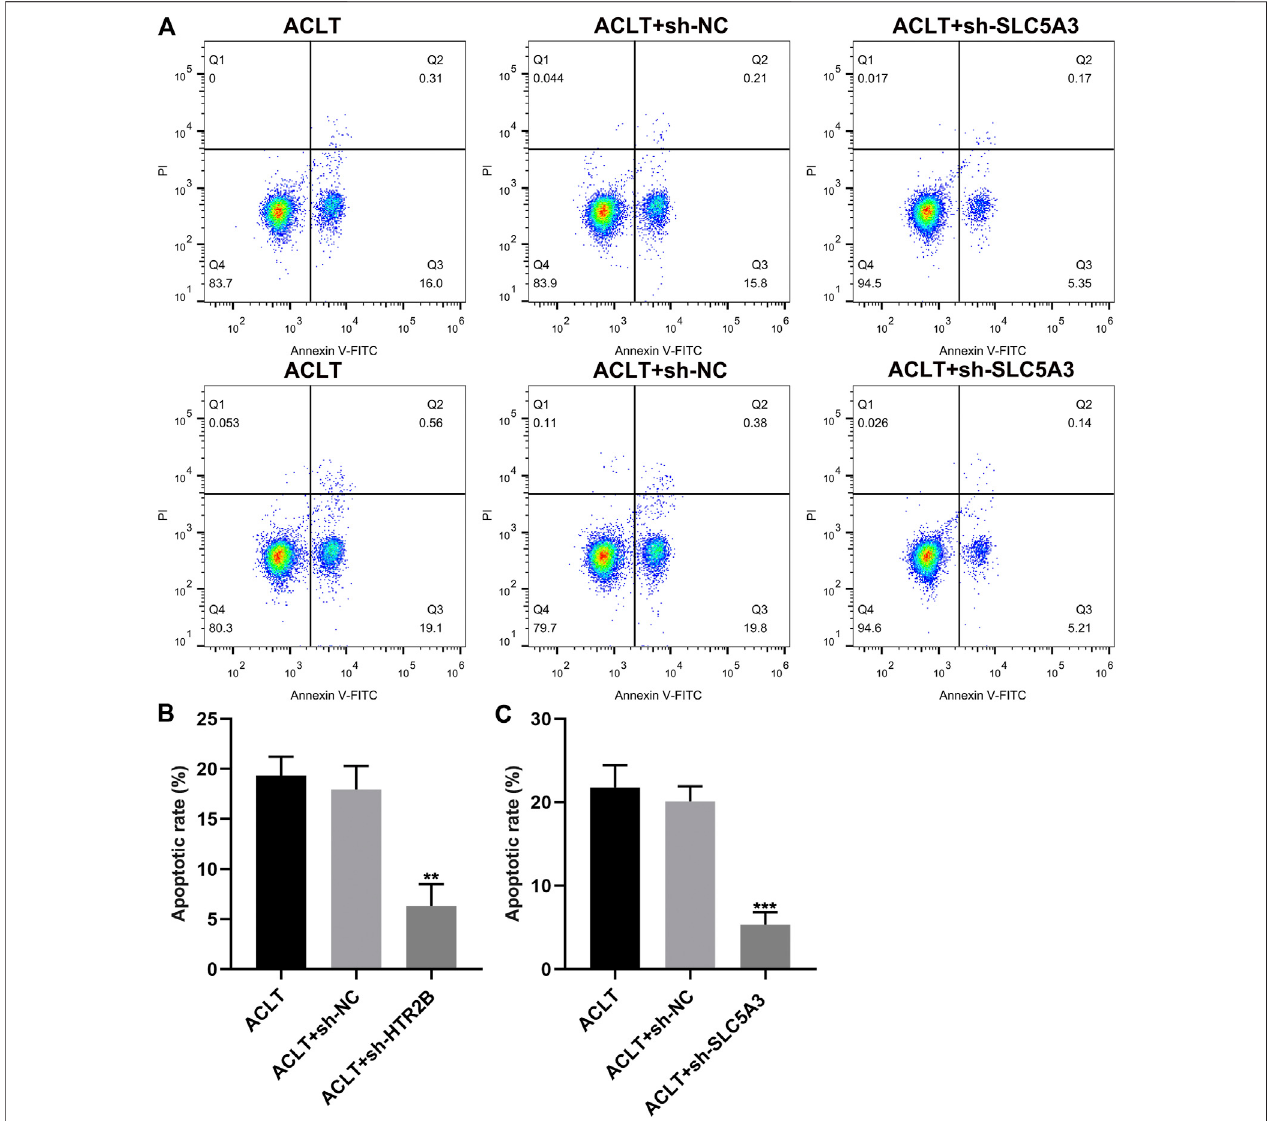
FIGURE 8 | The effects of HTR2B or SLC5A3 knockdown on apoptotic levels of OA synovial cells. (A) Representative images of fl ow cytometry of OA synovial cells transfected with sh-HTR2Borsh-SLC5A3. (B,C) Determination ofapoptotic levelsofOAsynovialcells transfected with sh-HTR2Bor sh-SLC5A3.** p < 0.01; *** p < 0.001.